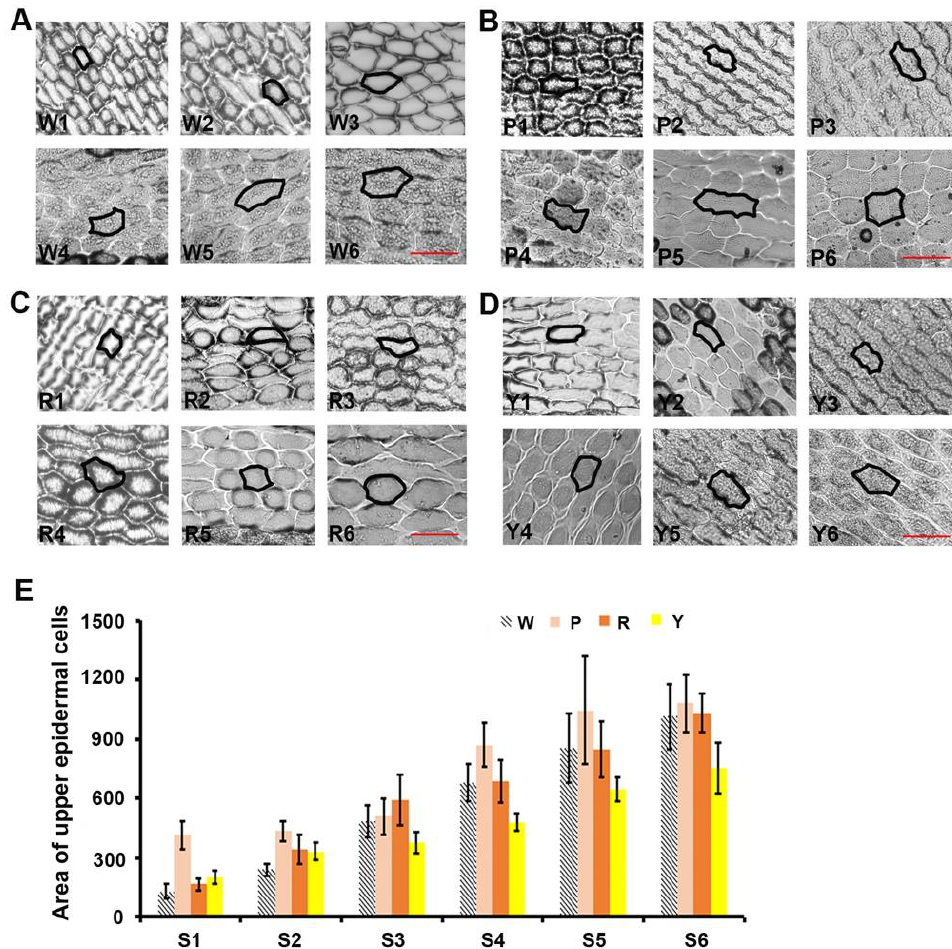
Figure 2. The observation of upper epidermal cells of ray florets of four colored chrysanthemums during the flowering period. ( A ) The picture of upper epidermal cells of ray florets of white chrysan- themums. W1 to W6 correspond to six stages of flowering period. ( B ) The picture of upper epidermal cells of ray florets of pink chrysanthemums. P1 to P6 correspond to six stages of flowering period. ( C ) The picture of upper epidermal cells of ray florets of red chrysanthemums. R1 to R6 correspond to six stages of flowering period. ( D ) The picture of upper epidermal cells of ray florets of yellow chrysanthemums. Y1 to Y6 correspond to six stages of flowering period. ( E ) The relative area of upper epidermal cells of four chrysanthemum cultivars in six flowering stages. W stands for white chrysanthemums; p stands for pink chrysanthemums; R stands for red chrysanthemums; Y stands for yellow chrysanthemums. Bar = 100 µm.